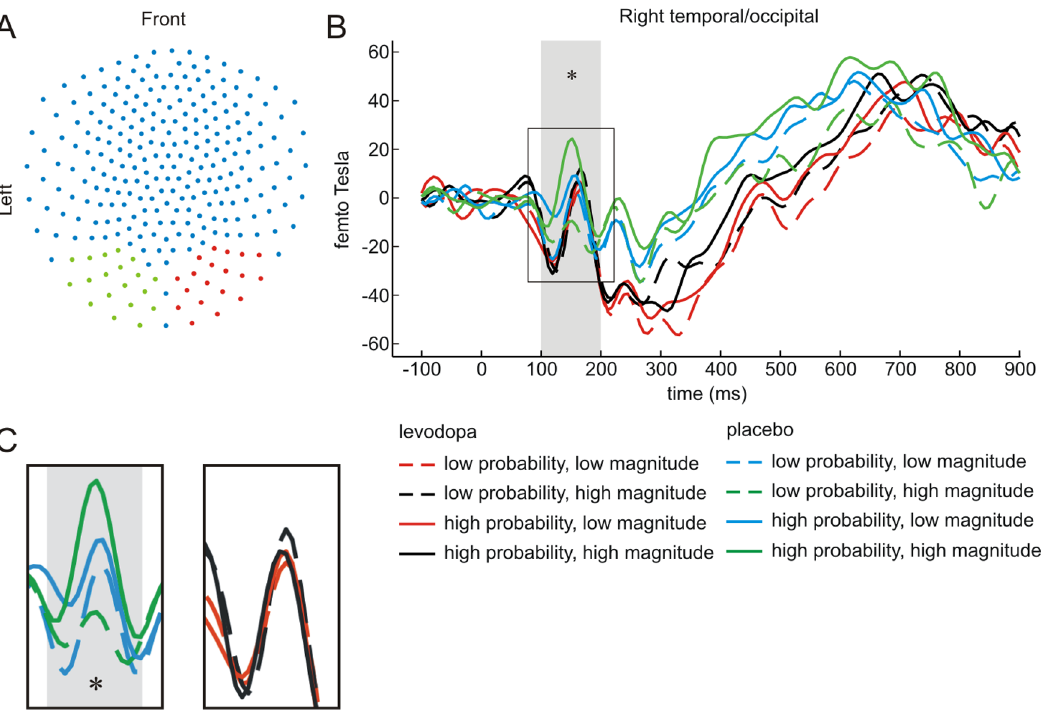
Figure 2. ERFs for reward predicting cues. An interaction effect between reward probability (high/0.7, low/0.3) and drug group (levodopa, placebo) was observed at a priori defined sensor groups of interest (red and green dots in A, see text) in the time window of 100 to 200 ms (B). This interaction was driven by a significant probability effect in the placebo but not levodopa group. C shows a magnification of this effect. Asterisk indicates the statistical significant interaction ( p , 0.05).